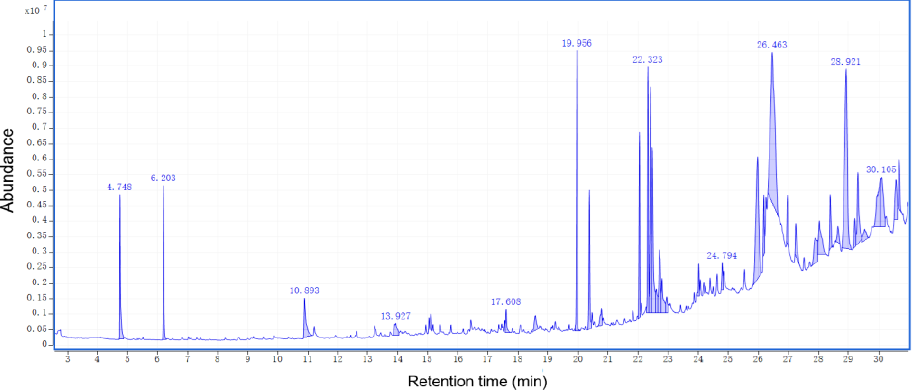
Figure 12. Total ion chromatograms of RPB ethanol/benzene (1:1) extract.